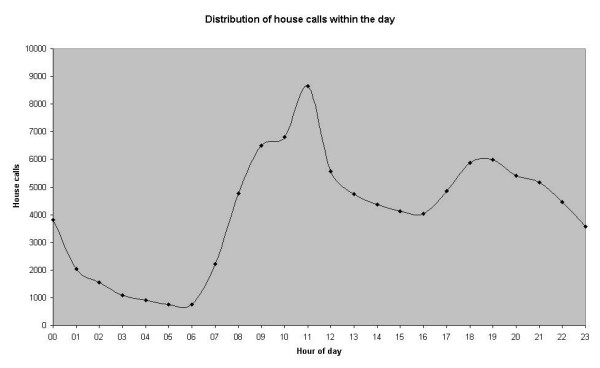
Distribution of house calls within the day.